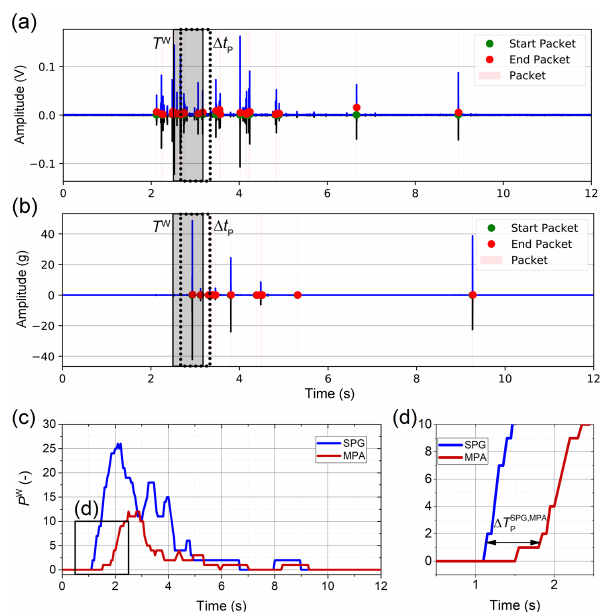
Figure C1. Illustration of the vibrations, signal packets, and packet number counts following a flume experiment with bedload parti- cles of grain-size class C4 and a flow velocity of 3.3ms − 1 . Pan- els (a) and (b) are representative signals that were recorded by the SPG and MPA systems, respectively. (c, d) Counting the number of packets and summing the numbers within the given time win- dow (gray-shaded area in a and b ). The blue and red lines are the summed number of packets in each time window for the SPG and MPA systems,